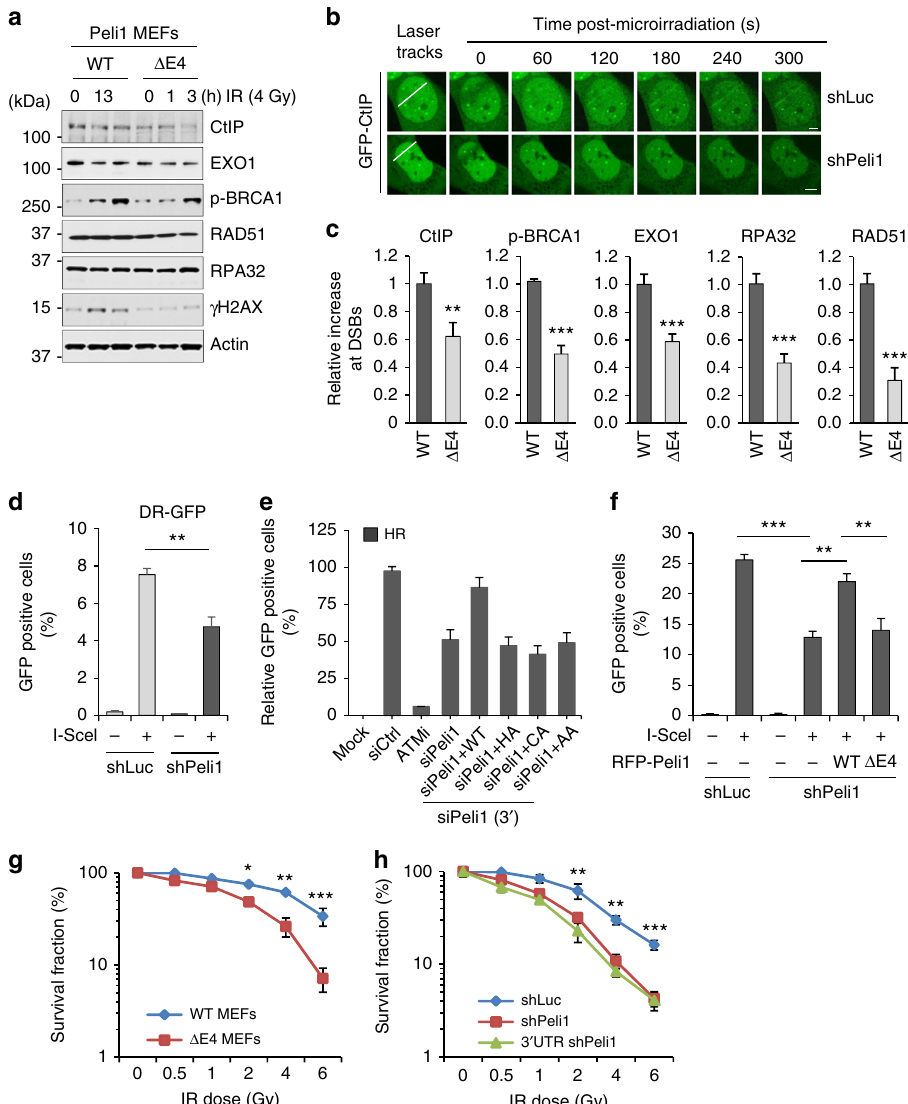
Fig. 9 Peli1 involves DNA-end resection for HR repair. a Peli1 WT and E4 truncated MEF cells were treated with IR (4 Gy). At 0, 1, and 3 h post-IR, cells were collected and immunoblotted. b U2OS cells stably expressing GFP-CtIP were transfected with shLuc or shPeli1. After 48 h, cells were subjected to laser micro-irradiation. Laser stripes were examined at indicated time points. Scale bars, 10 μ m. c Peli1 WT and E4 truncated MEF cells were micro- irradiated at 10 min for CtIP and p-BRCA1, at 30 min for Exo1, RPA32, and Rad51. Fixed cells were immunostained with indicated antibodies. All data are presented as mean values ± SEM of three independent experiments; n = 20 cells. Student ’ s t -test was used for statistical analyses. d , e U2OS HR reporter cells were transfected with shRNA targeting Peli1 or control ( d ), or siRNA-targeting Peli1 3 ′ -UTR region and Myc-Peli1 WT, RING mutants (HA and CA), and phospho-dead mutant (AA) in combination as indicated ( e ). After 24 h, I- Sce I nuclease-expressing vector was transfected into reporter cells.